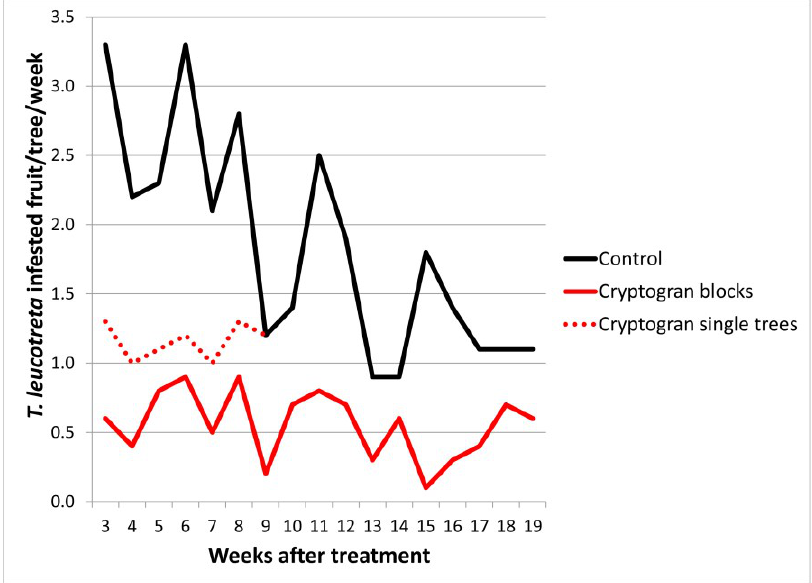
Figure 2. Thaumatotibia leucotreta -infested fruit per tree per week at Carden Farm. The trial was sprayed on 3 December 2003. (See Table 3 for full treatment application details; see Table 1 for means and standard errors for the full period of